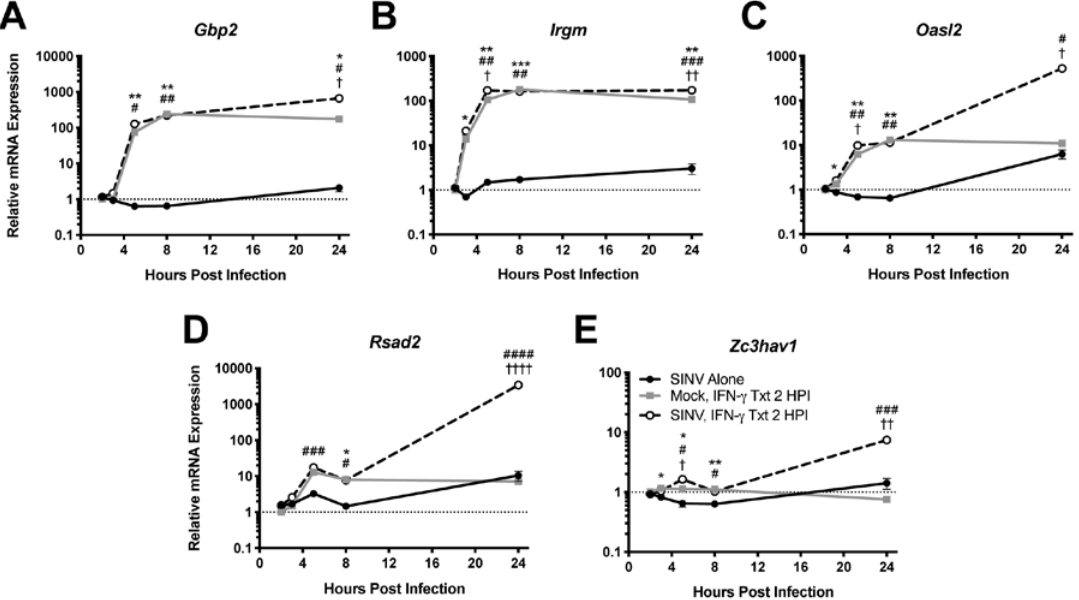
Figure 2. E ff ect of IFN- γ treatment on ISG expression during SINV infection in vitro. ISGs selected for examination by qRT-PCR in dAP-7 cells infected with SINV at a MOI of 1 and left untreated (black circle and solid line), mock-infected and treated with 500 U / mL IFN- γ at 2 HPI (gray square and solid line), or SINV-infected at a MOI of 1 and treated with 500 U / mL IFN- γ at 2 HPI (white circle and black dashed line) included Gbp2 ( A ), Irgm ( B ), Oasl2 ( C ), Rsad2 ( D ), and Zc3hav1 ( E ) ( n = 3 replicates per group; data are representative of two independent experiments and are presented as the mean ± SEM; dashed line indicates gene expression of untreated, mock-infected cells to which other groups were normalized; * p < 0.05, ** p < 0.01, *** p < 0.001, SINV Alone vs. Mock, IFN- γ Txt 2 HPI; # p < 0.05, ## p < 0.01, ### p < 0.001, #### p < 0.0001, SINV Alone vs. SINV, IFN- γ Txt 2 HPI; † p < 0.05, †† p < 0.01, †††† p < 0.0001, Mock, IFN- γ Txt 2 HPI vs. SINV, IFN- γ Txt 2 HPI, all by Tukey’s multiple comparisons test ).